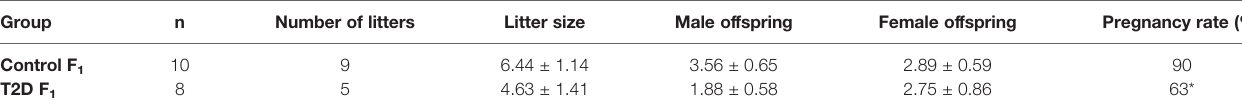
TABLE 4 | Reproductive effects of T2D in parental generation on the F 1 offspring. Group